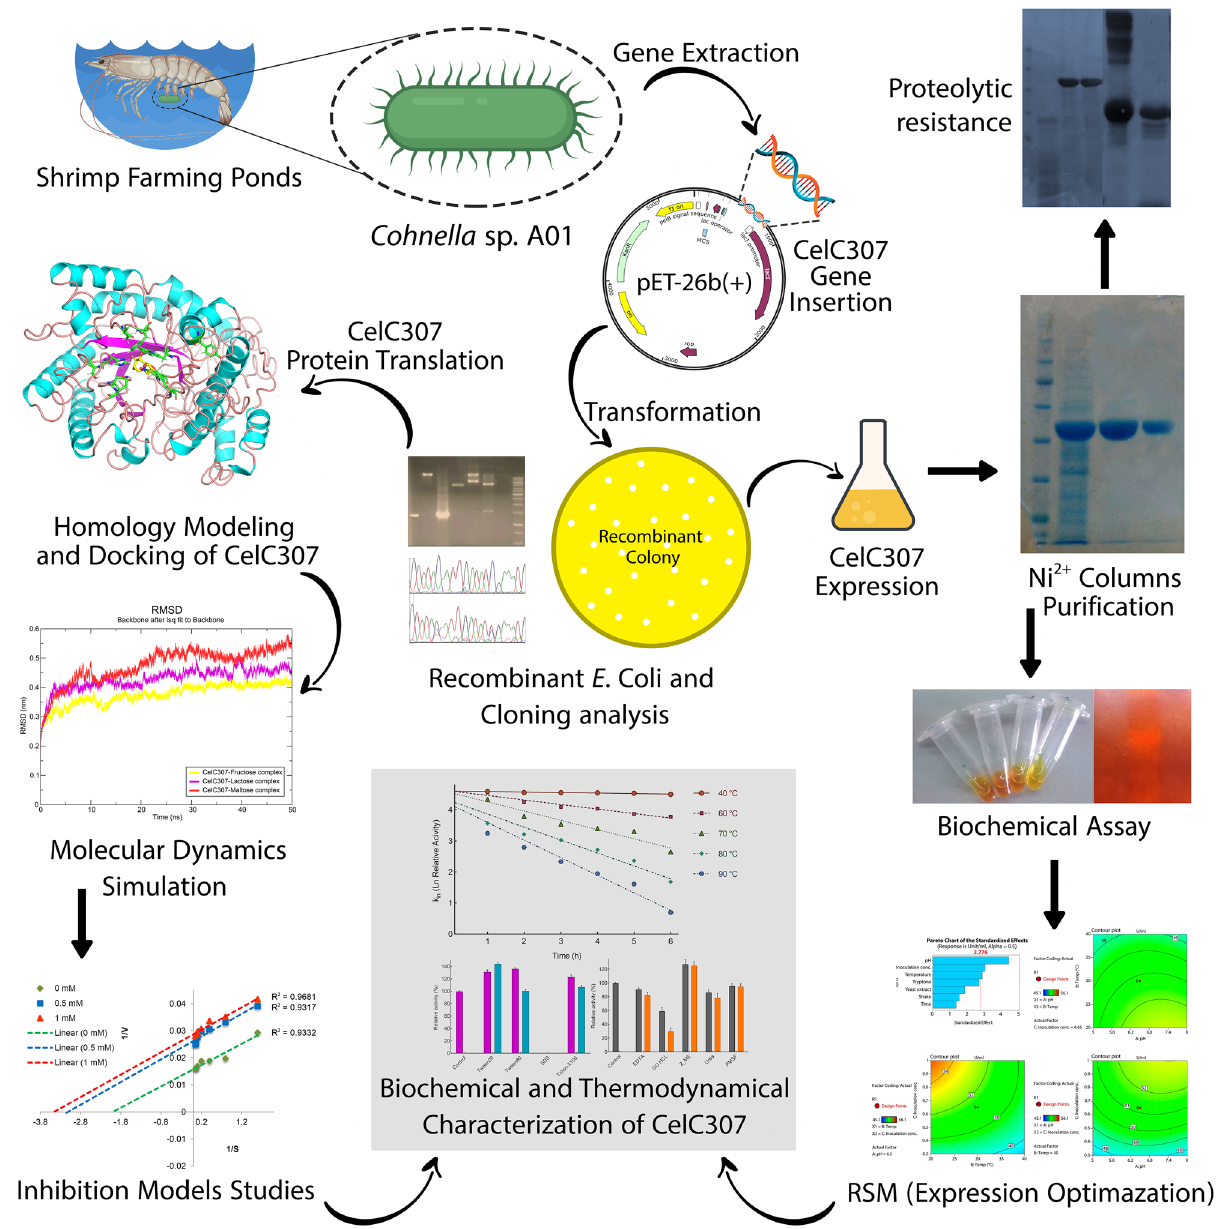
Figure 1. Flowchart summarizing the steps of CelC307 biochemical characterization and product optimization. Flowchart has been created by Biorender (BioRender.com) and Illustrator